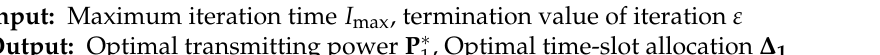
Algorithm 1 Traffic load optimization algorithm in scenario